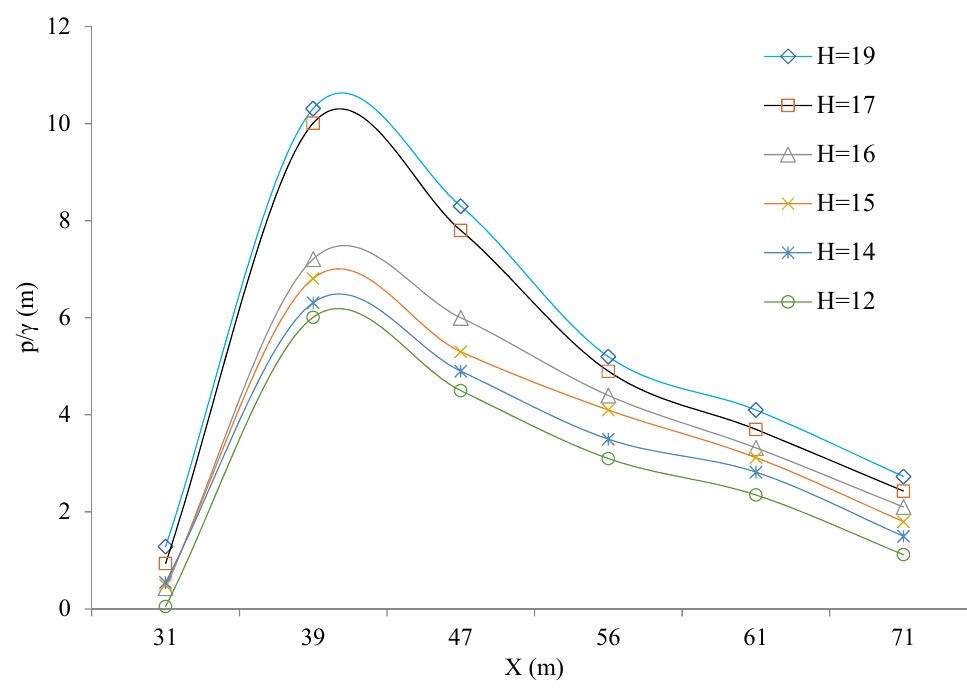
Figure 9. Spillway chute pressure distribution for M 4 .